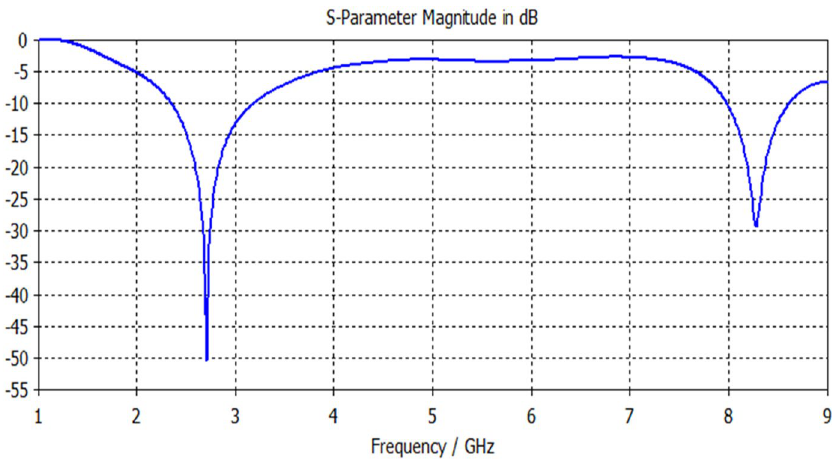
Figure 5. S11 response of Antenna1.